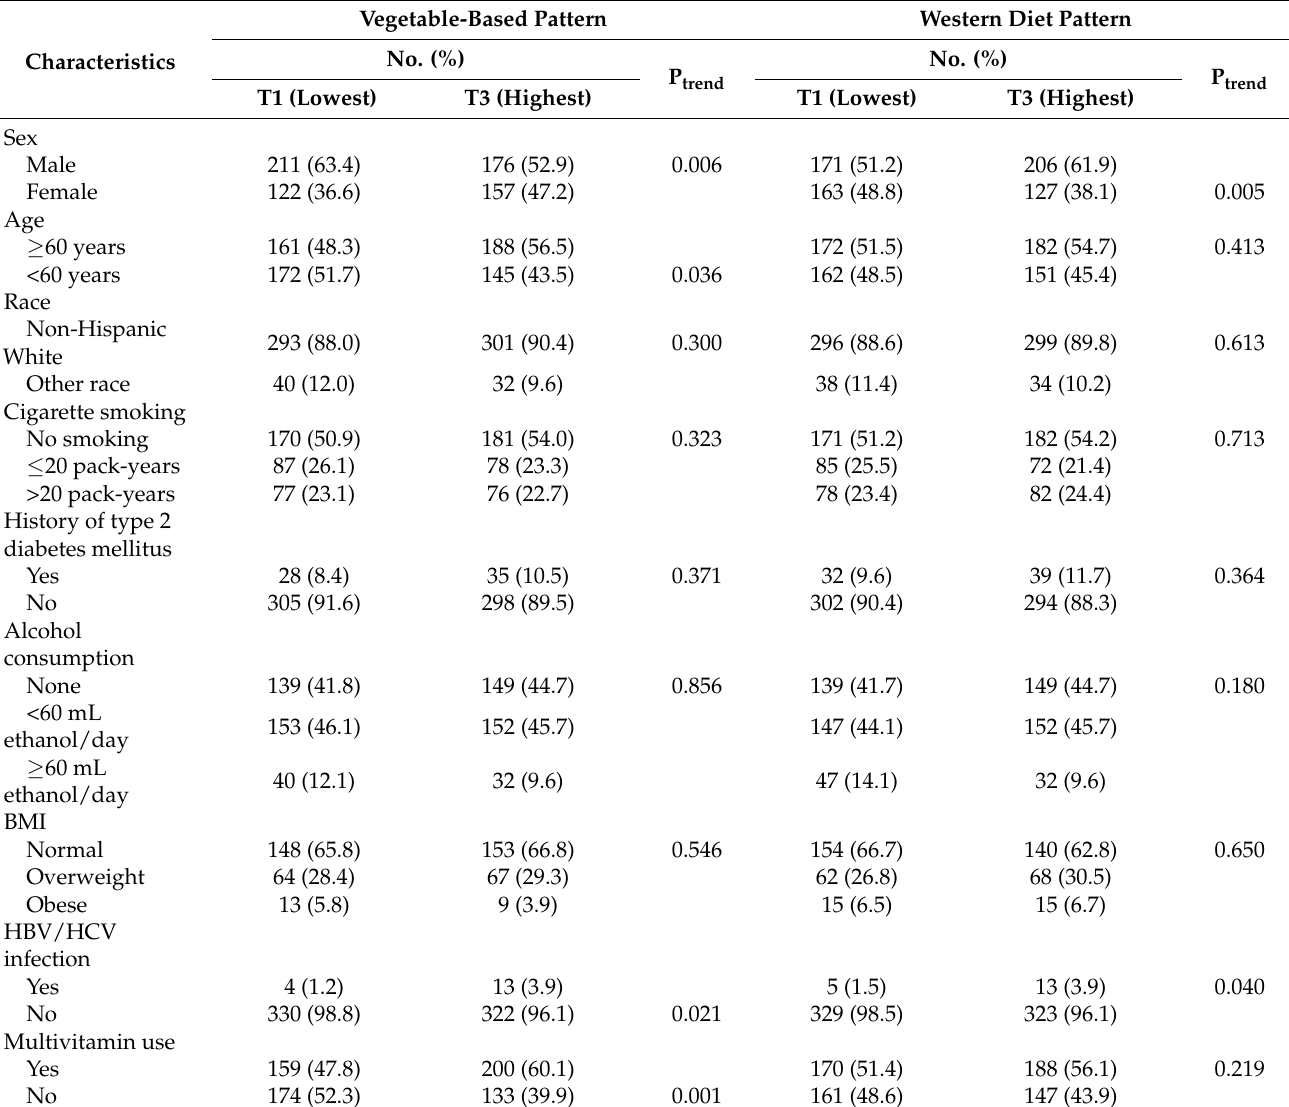
Table 4. General characteristics of controls according to tertile of dietary pattern